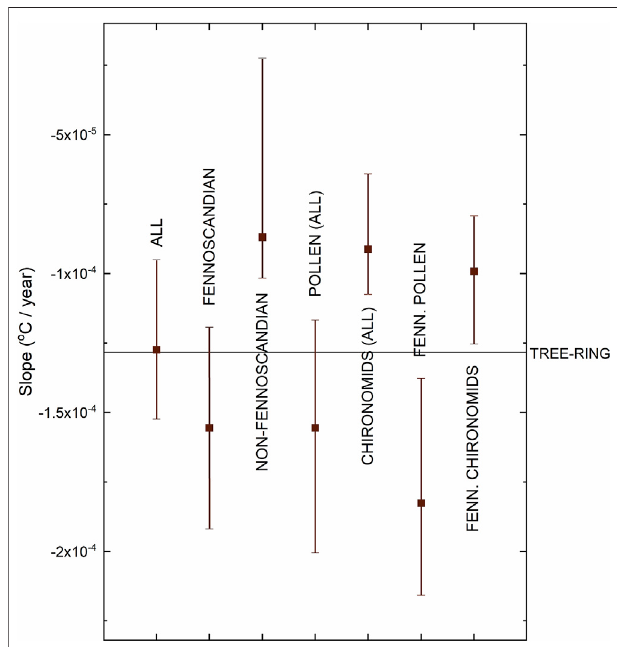
FIGURE 7 | Cooling on orbital scales. Comparison of the slopes in our tree-ring – based temperature record from the minimum blue channel light intensity of subfossil wood and in temperature records of other proxy types representing high-latitude sites (north of 60 ° N) (Sundqvist et al., 2014) (see Figure 1A for site locations) between 7,440 and 140 cal BP. Medians of the slope are shown with 95% con fi dence intervals for all non – tree-ring records ( n = 87), Fennoscandian ( n = 45), non-Fennoscandian ( n = 42), pollen ( n = 67), chironomid ( n = 20), Fennoscandian pollen ( n = 26), Fennoscandian chironomid ( n = 14), and Fennoscandian diatom ( n = 6) records. Negative slopes indicate long-term cooling. The horizontal line denotes the slope estimate of our tree-ring – based temperature record. For actual values, see Supplementary Table S2